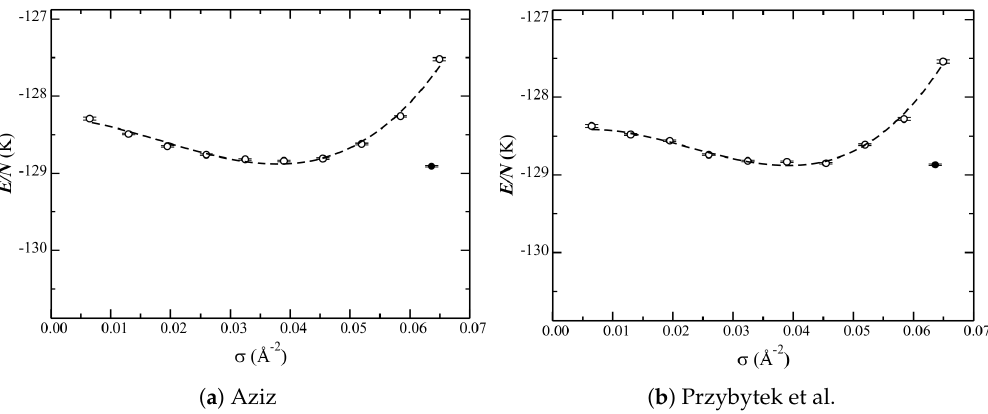
(abbreviated as He